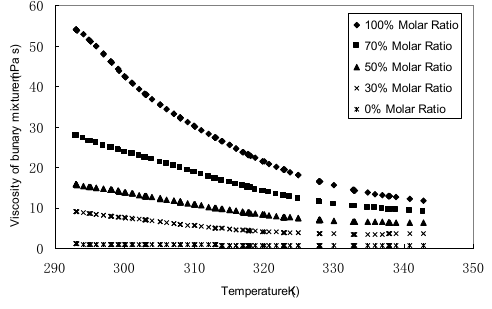
Fig. 5.5 Viscosity predictions with varying amounts of molar ratio for [C 4 -mim][NTf 2 ]-ethanol mixture at temperature range